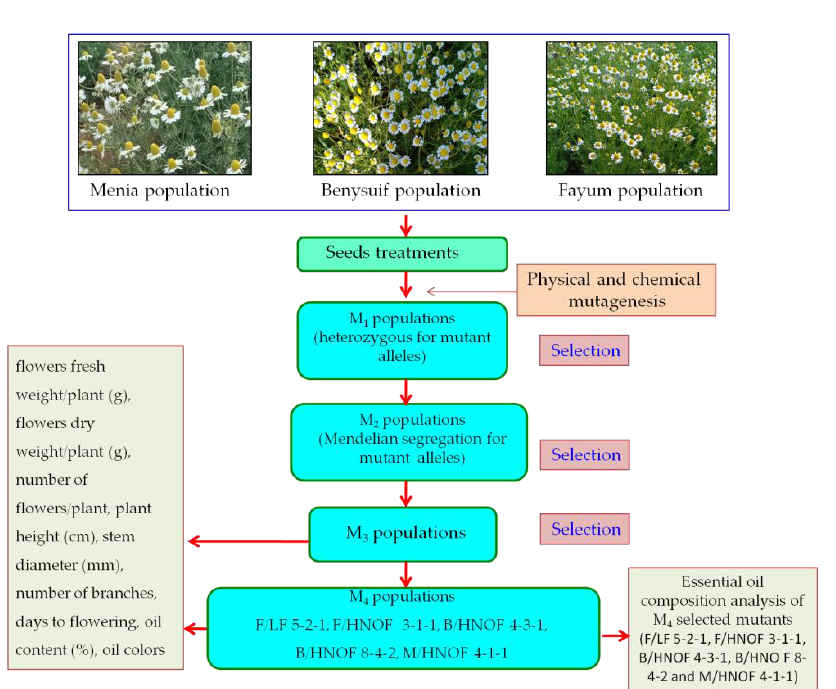
Figure 3. General procedures of the field experiments for the induction of promising mutations of three populations of German chamomile.